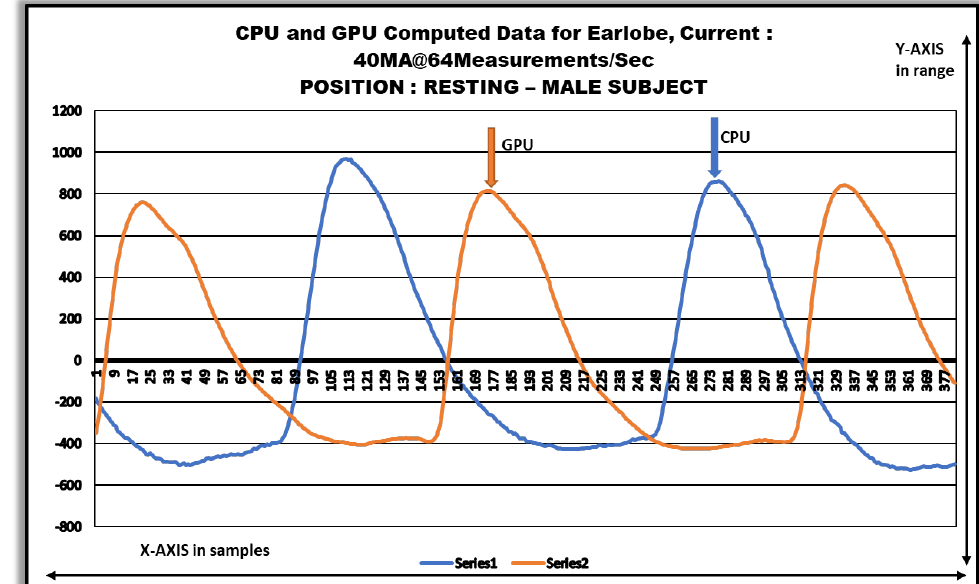
Figure 17. Parallelly computed GPU and CPU data using Earlobe.